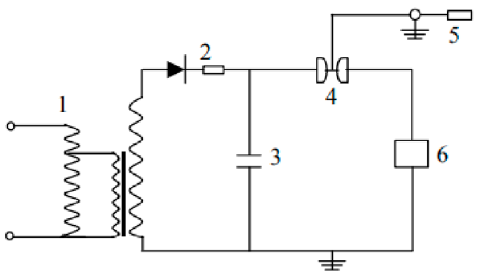
Figure 1. Schematic diagram of electro-explosive spraying experiment: 1—transformer; 2—ballast; 3—storage capacitor bank; 4—air switch; 5—grounding device; and 6—electric explosive chamber.